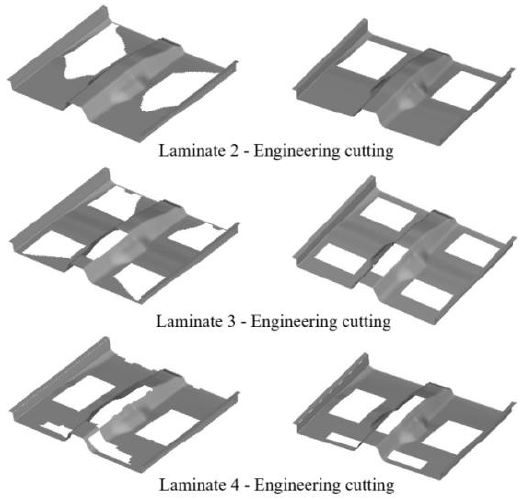
Figure 20. Comparison of the shape of the layer blocks before and after the 45 ° super layer cut.